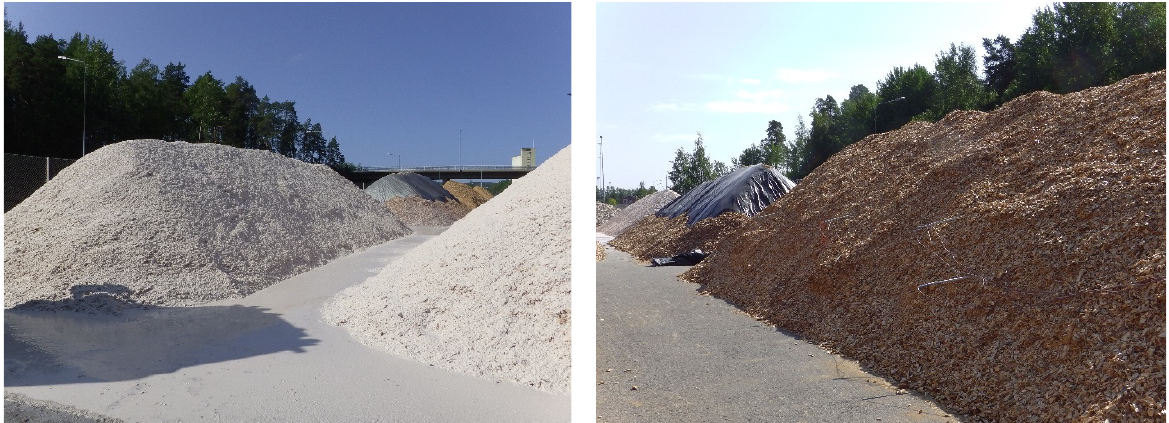
Figure 2. Established experiment, with stemwood chip piles at Kuopion Energia’s paved terminal premises. The experiment included two uncovered piles, two covered with plastic, and two covered with Livetech Suoja ® material (bio-pile cover). Source: Luke/Robert Prinz. The material originated from a mix of imported stemwood chips predominantly of Norway spruce ( Picea abies (L.) H. Karst) and Scots pine ( Pinus sylvestris ), the pre-storage time was unknown. The material was delivered by truck directly from the fuel suppliers and unloaded at the paved terminal premises. Following the order of arrivals, chips were piled with a wheel loader and an excavator to the designated pile size; thus, an unspecified degree of homogenisation of the material within each pile occurred. The piles had an average size of 18.0 × 5.0 × 3.5 m (length, width, height). The volumes of the piles were measured using an unmanned DJI Phantom 4 RTK SDK aerial vehicle (UAV). By